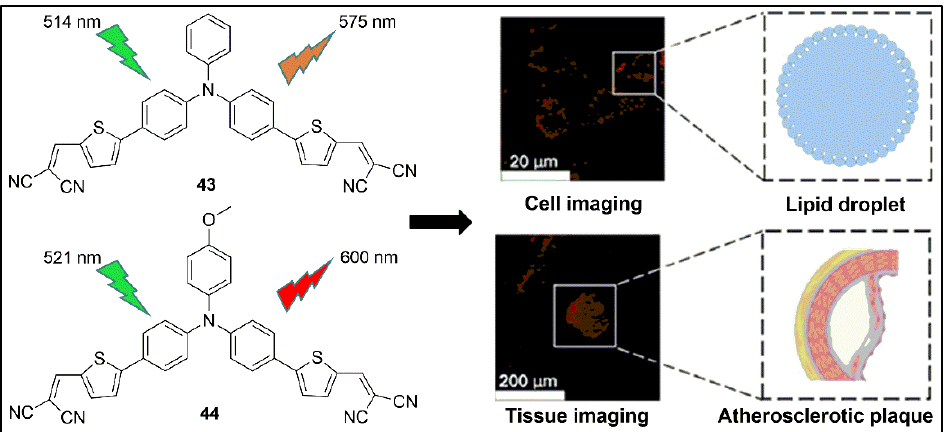
Figure 44. Illustration of 43 and 44 and their LDs-specific cell and atherosclerosis imaging. Adapted with permission from [141]. Copyright (2023) Elsevier.